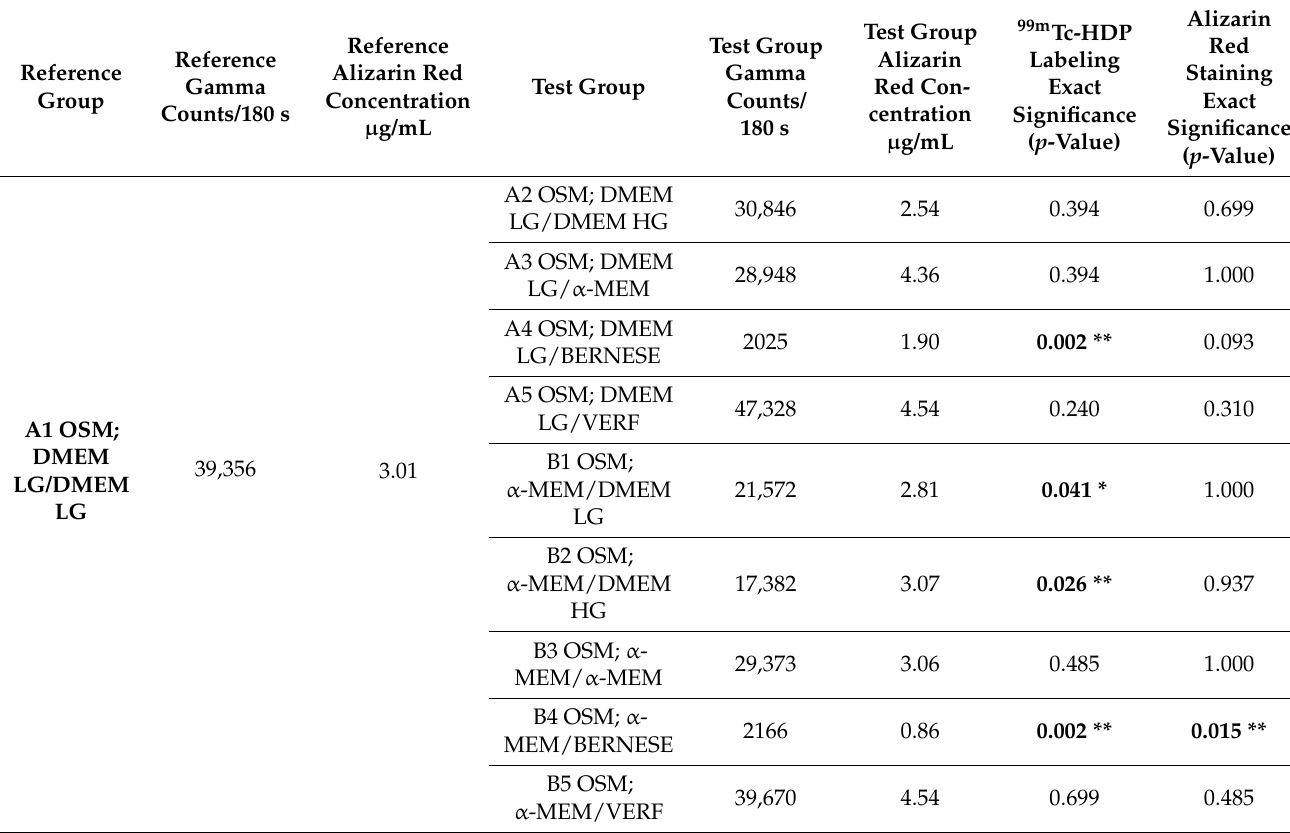
Table 2. Mann–Whitney Test for all osteogenic groups (OSM) when group A1 OSM is defined as